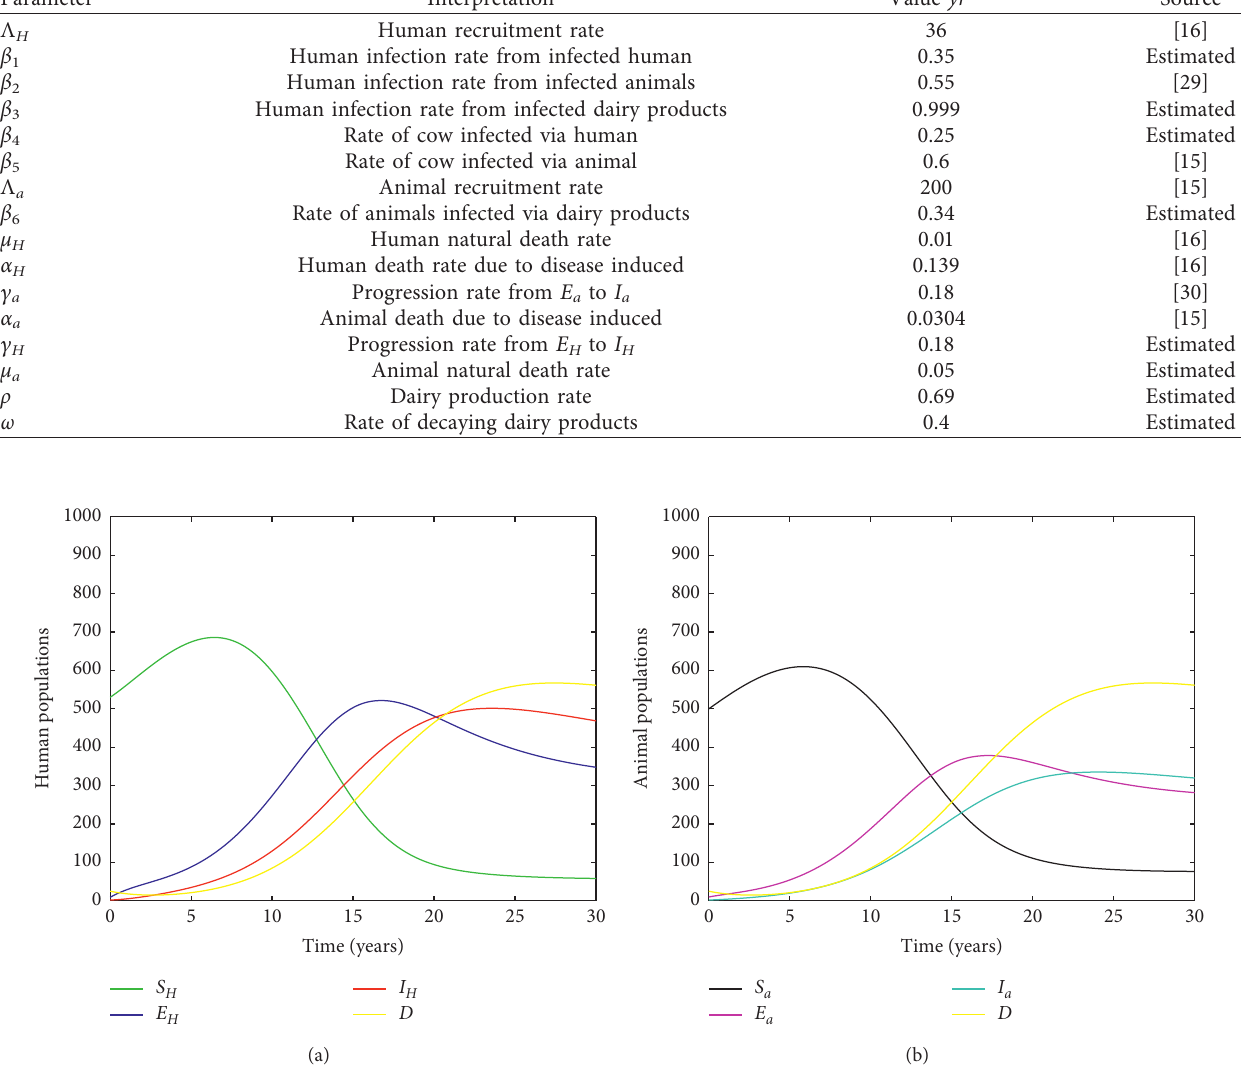
Figure 2: Dynamics of bTB in (a) human population and (b) animal